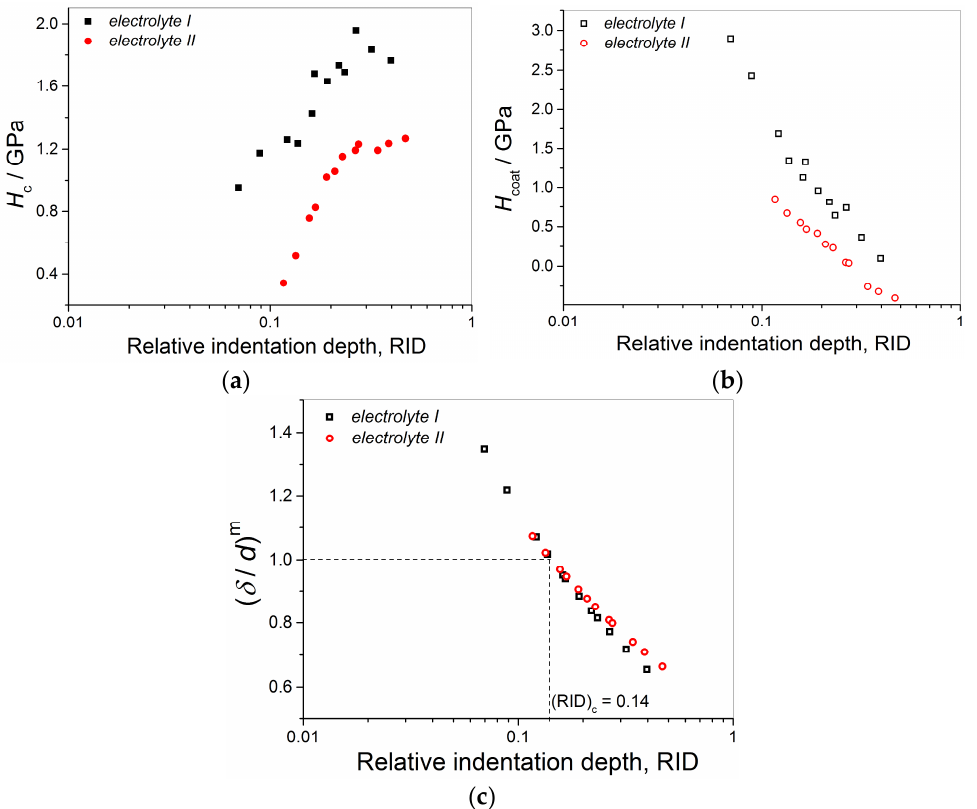
Figure 7. The dependencies of ( a ) the composite ( H c ) and ( b ) the calculated coating ( H coat ) hardness on the RID for the 20 µm thick Cu coatings electrodeposited on the Si(111) from electrolytes I and II , and ( c ) the dependencies of ( δ / d ) m on the RID for the same Cu coatings.